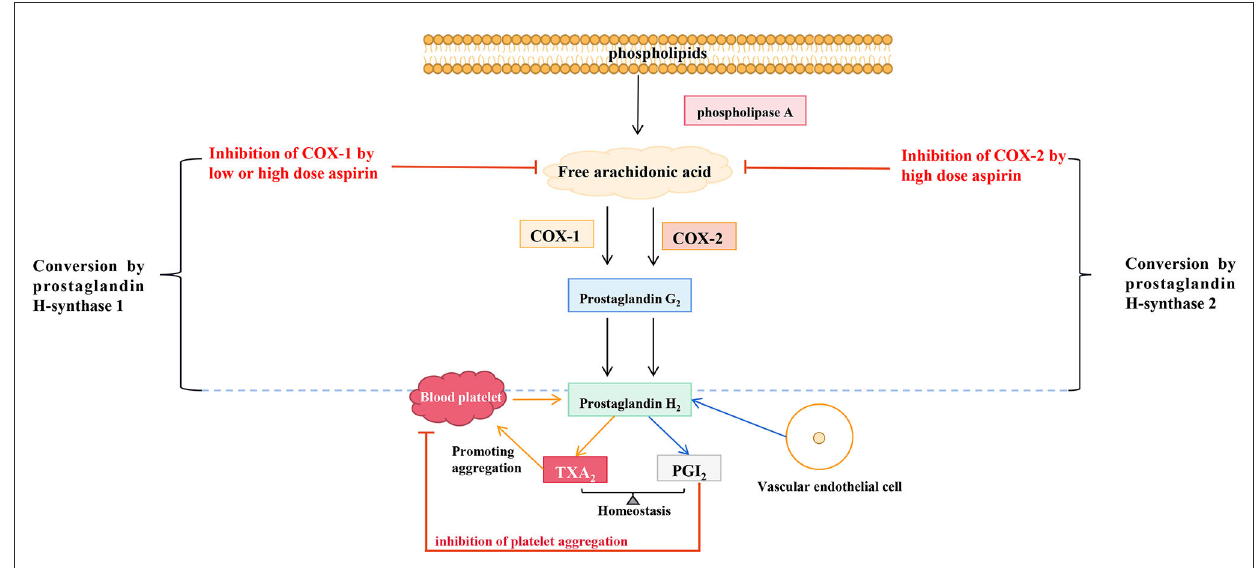
FIGURE1 The in-vivo mechanism of aspirin in endothelium and blood